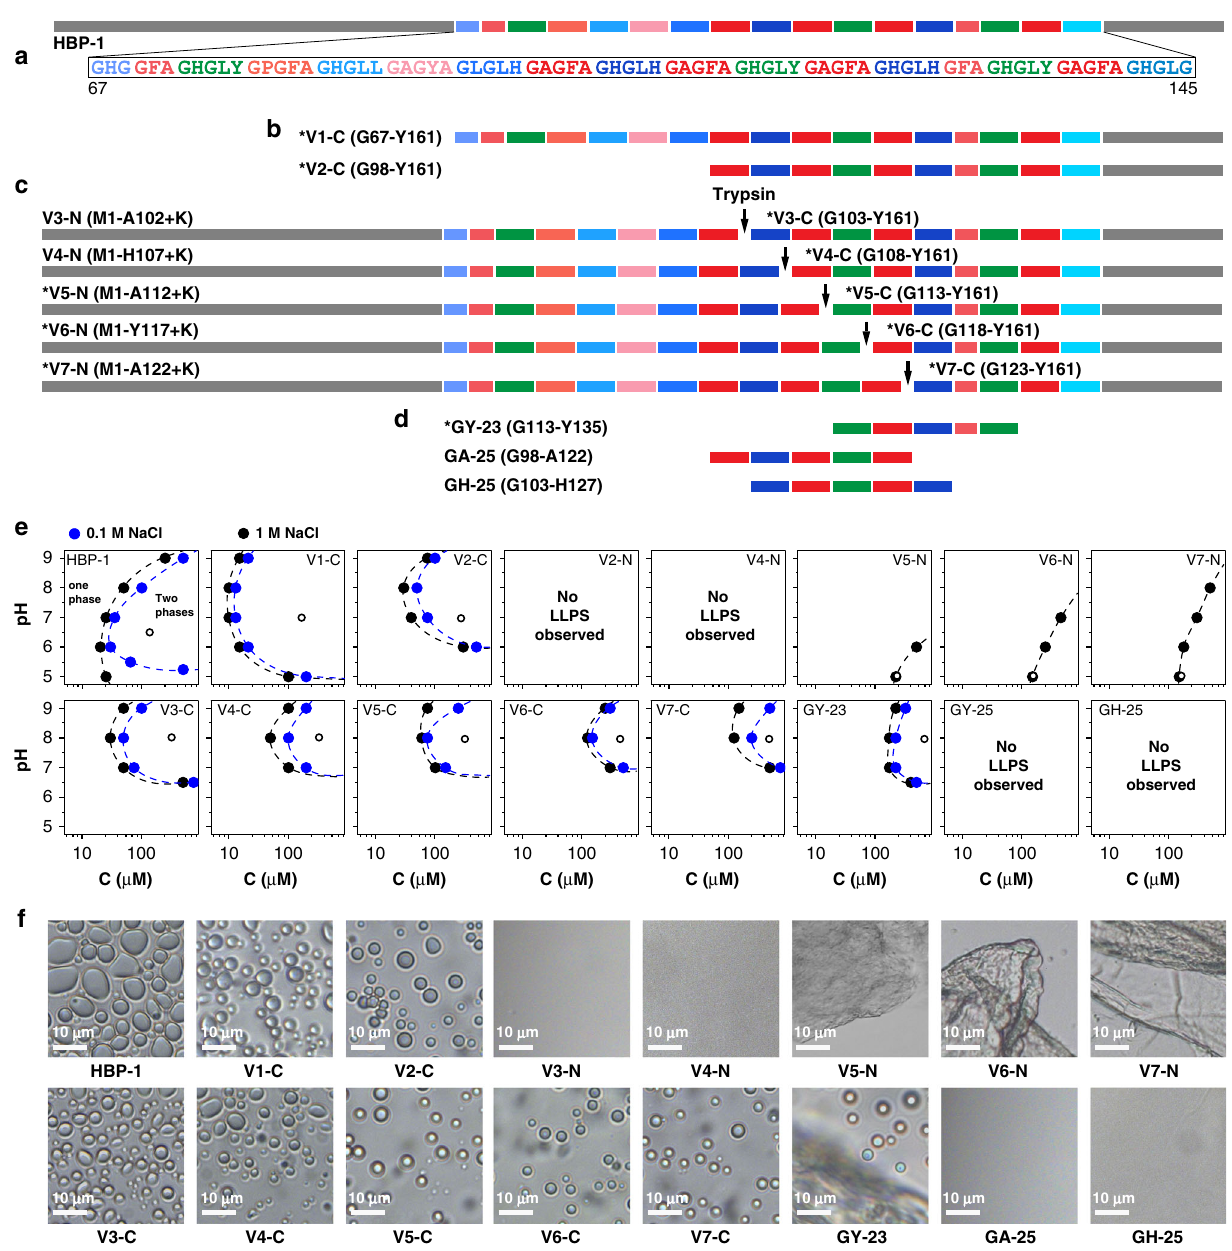
Fig. 2 Analysis of LLPS properties of HBP-1 N- and C- terminal variants and peptides. a Amino acid sequence representation of HBP-1 protein. The repetitive region (G67 – G145) is presented with modular repeats indicated with different color shades for motifs containing His (blue) or hydrophobic residues (red), and for the GHGLY motif (green). Non-repetitive N- and C-terminal regions are marked in gray. b C-terminal variants (V1-C containing the whole repetitive region, and V2-C truncated at position G98). c N- and C- variants obtained by trypsin cleavage. d Synthetic peptides. The same color marking was used for all peptides shown. Full amino acid sequences of all proteins and peptides are presented in Supplementary Figs. 1 and 7. Region of the HBP-1 sequence indicted in brackets. Variants that undergo LLPS marked with *. e Phase diagrams (protein or peptide concentration (C) on x -axis and pH on y -axis) at low (0.1 M) and high (1 M) salt concentrations, illustrating the conditions required to induce LLPS. As indicated in the upper-left panel (HBP-1), at low protein concentration only one phase is present (soluble protein). When LLPS occurs two phases co-exist, i.e. protein rich phase (coacervate microdroplets/ hydrogel) and protein depleted diluted phase (the boundary lines between two phases are drawn as a guide for the eye). Black empty dots indicate pH and protein concentration at which optical micrographs presented in panel ( f ) were obtained. Source data are provided as a Source Data fi le. f Examples of optical micrographs taken after LLPS of all the variants and peptides described above and of HBP-1 (used as a control). Micrographs of V5-N, V6-N and V7- N represent To further assess the role of the GHGLY motif, we compared and Supplementary Fig. 7c). Only GY-23 phase-separated, the coacervation ability of the HBP-1 derived GY-23 peptide forming coacervate microdroplets suspended in solution as well (containing two GHGLY copies) 32 with two other synthetic as a dense hydrogel-like structure (condensed, solid-like coacer- peptides made of very similar fragments of HBP-1 repeats (GA- vates, Fig. 2f). In contrast, GA-25 and GH-25 remained in 25 and GH-25), but harboring only one GHGLY motif (Fig. 2d